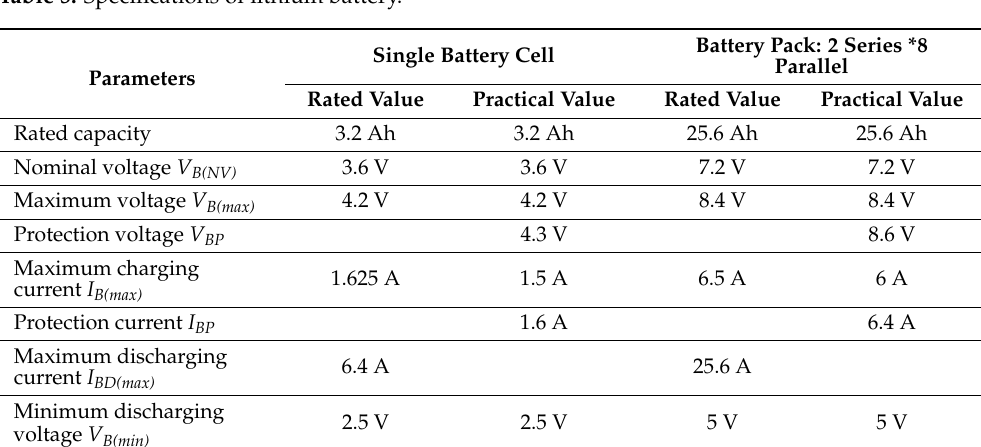
Table 5. Specifications of lithium battery.